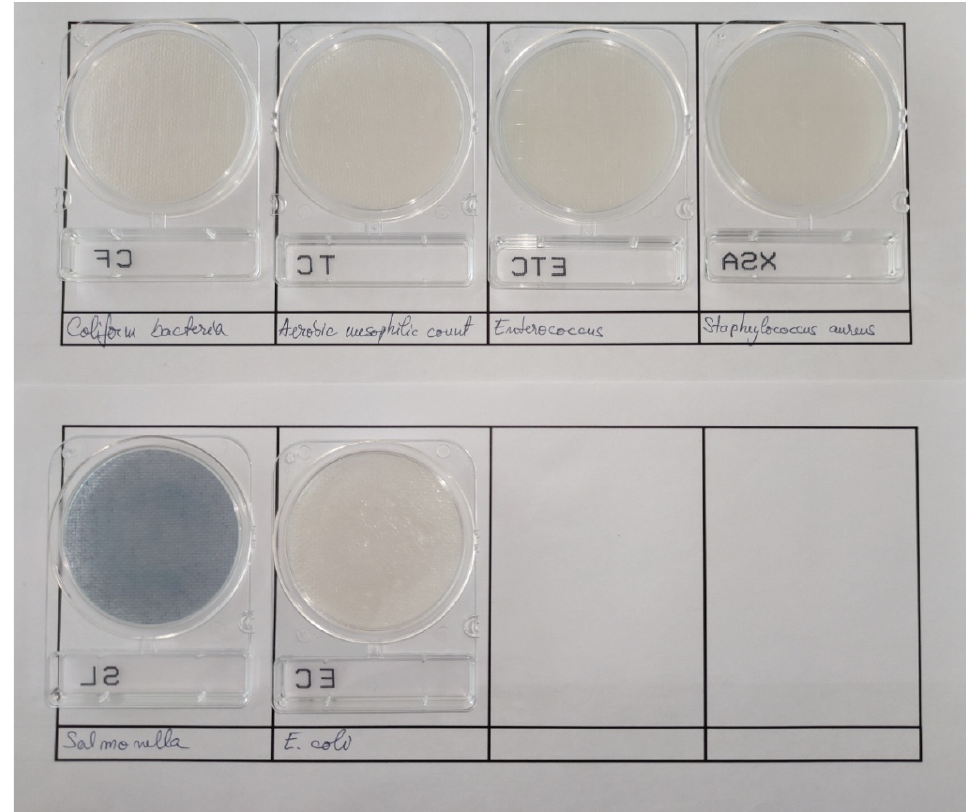
Figure 8. Results of microbiological tests for the optimal sample. No visible colonies were detected.